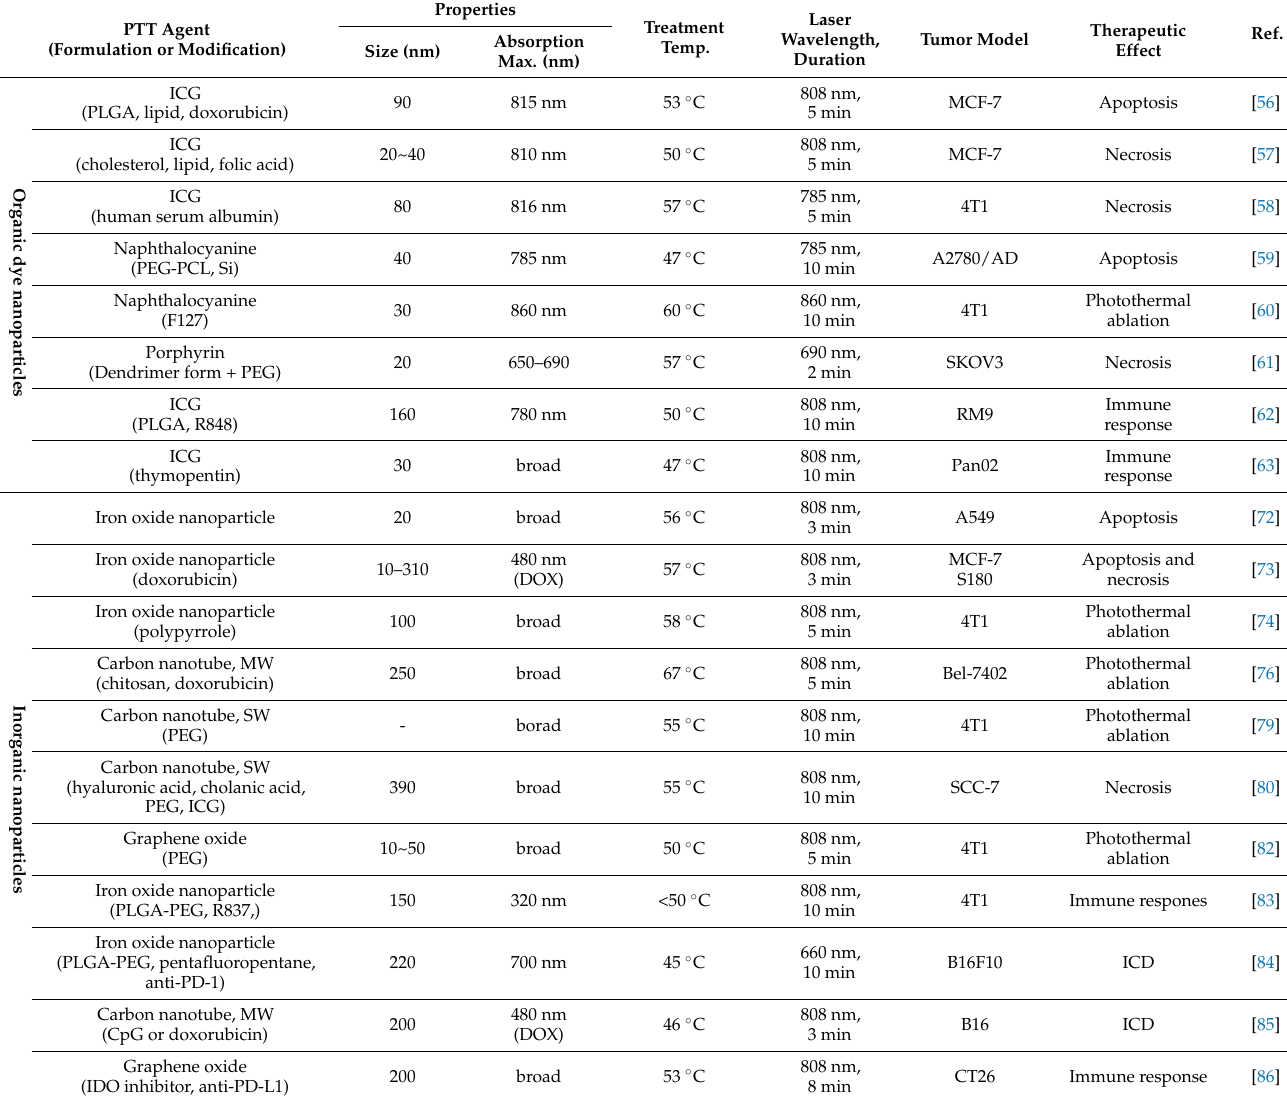
Table 1. Summary of nanoparticles for